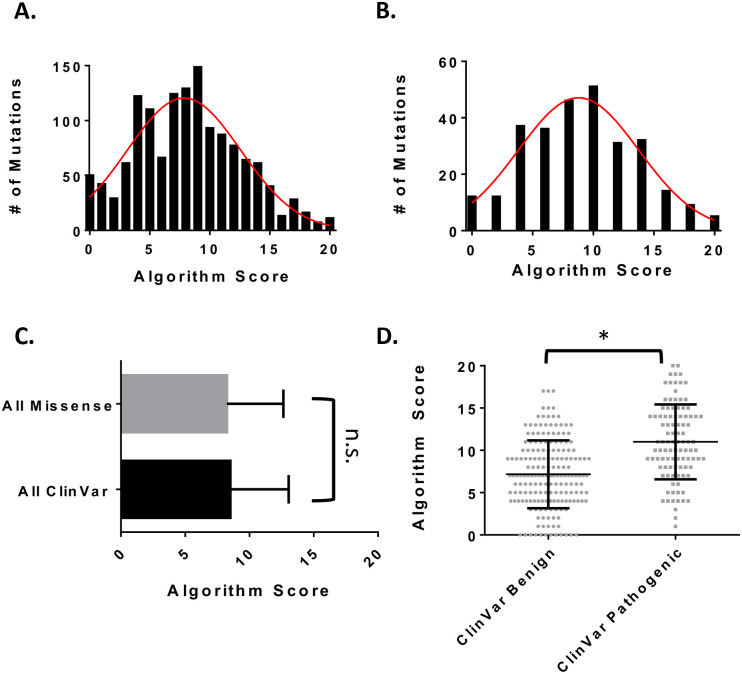
Score distributions for the VHL missense mutations used in the multiparametric approach.A. A fitted Gaussian distribution (red) of scores for all 1379 possible missense mutations from a SNP in VHL B. A fitted Gaussian distribution (red) of scores for the 285 ClinVar missense mutations used in this study. C. Relationship between the All Mutation data set and the ClinVar data set. D. Mutation algorithm scores plotted according to their ClinVar pathogenicity. Each dot is a mutation. All error bars represent the standard deviation. A * represents a P < .05 according to a Kolmogorov Smirnov test. All statistics done in Graph Pad Prizm.